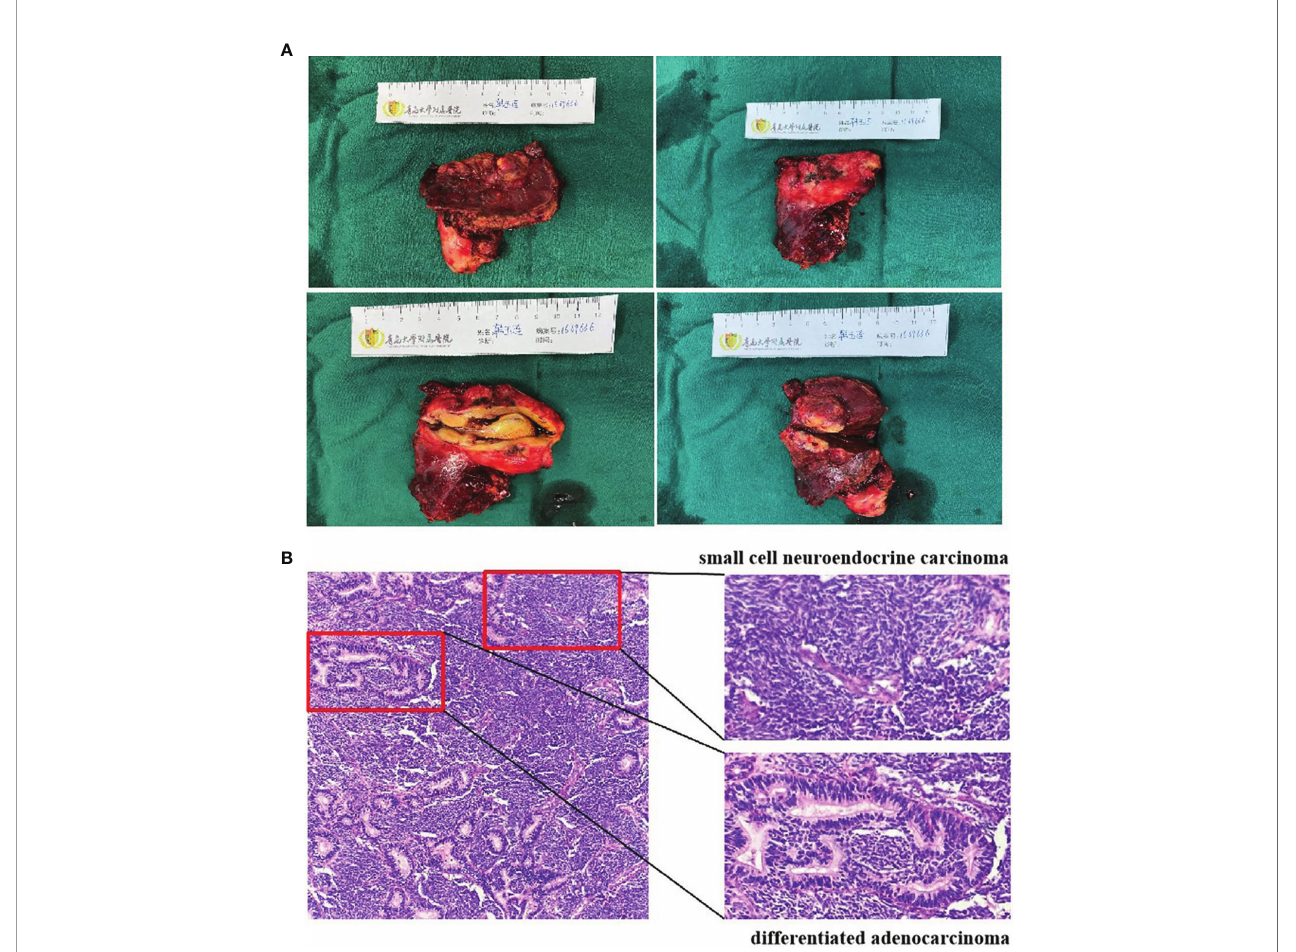
FIGURE 4 | Surgical photo (A) . Pathology results (B) . H&E staining of the surgical specimen showed mixed neuroendocrine – nonneuroendocrine